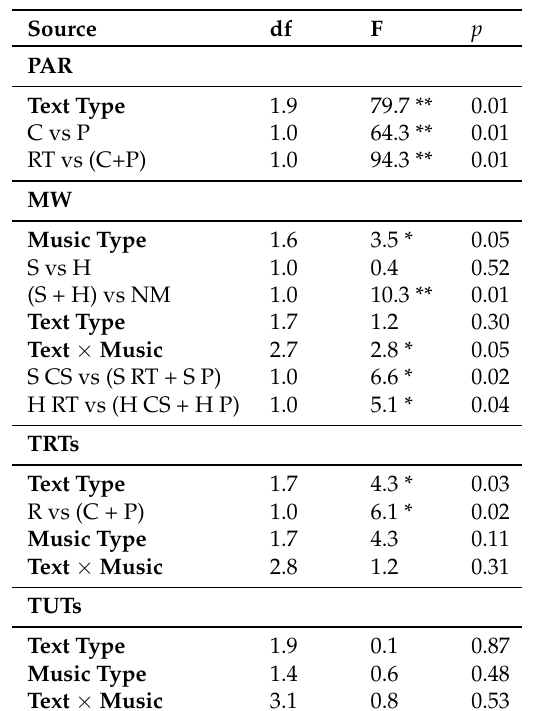
Table A1. Analysis of Variance. Bold font represents main and interaction